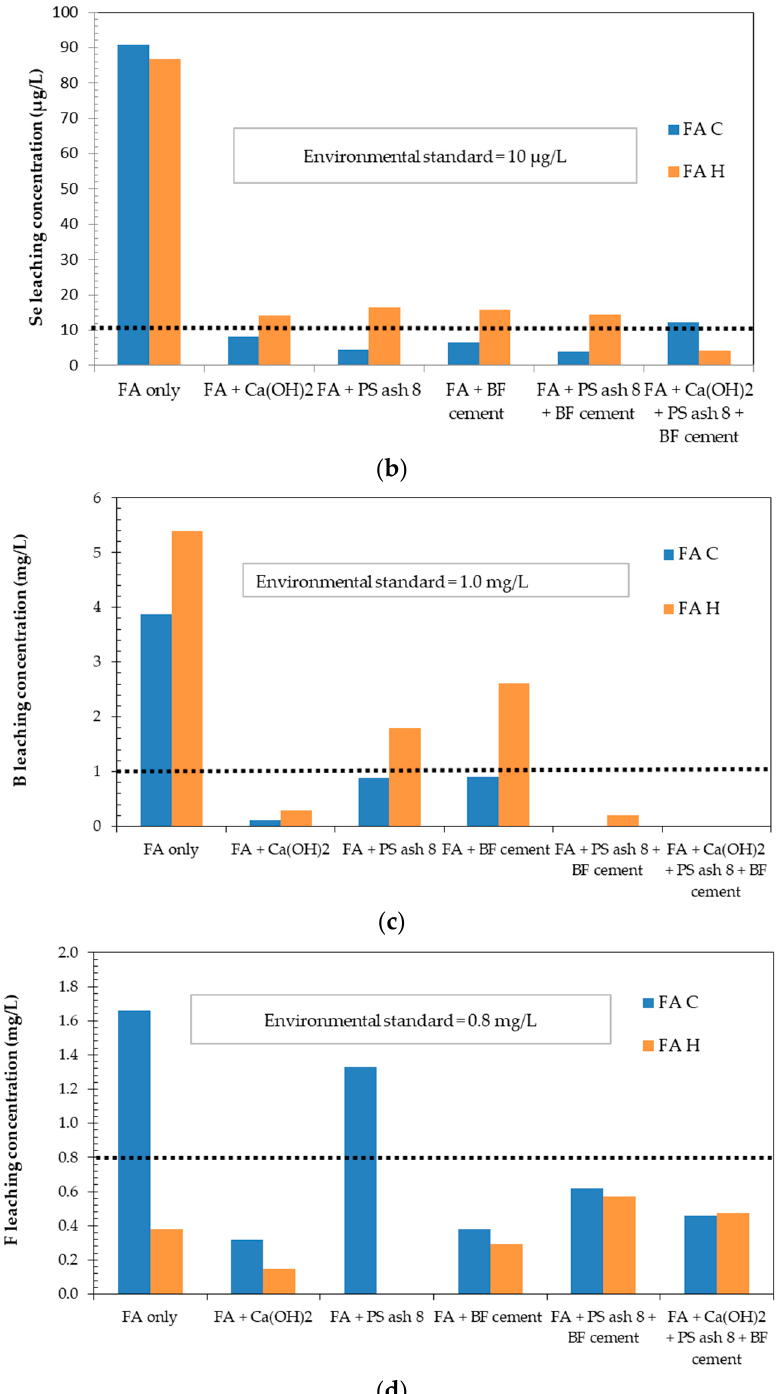
Figure 5. Effect of additive on ( a ) As, ( b ) Se, ( c ) B and ( d ) F leaching concentrations from two different coal fly